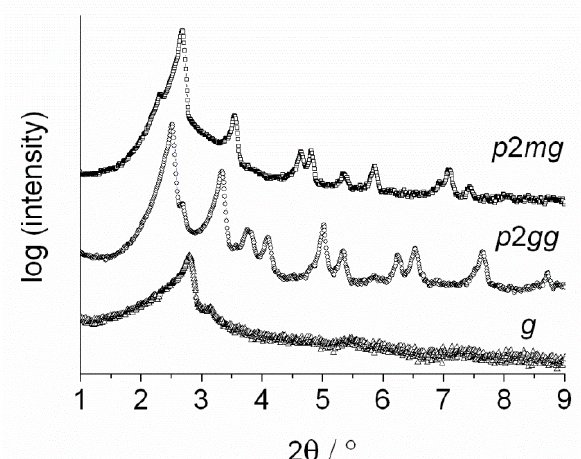
Figure 5. Small angle diffraction pattern of the new high temperature Col r -phase ( p 2 mg ) (□) at 220 °C, the already known col r -phase ( p 2 gg ) ( ○ ) at 180 °C and the solid state ( g ) at 20 °C (∆) of KSCN-2b .